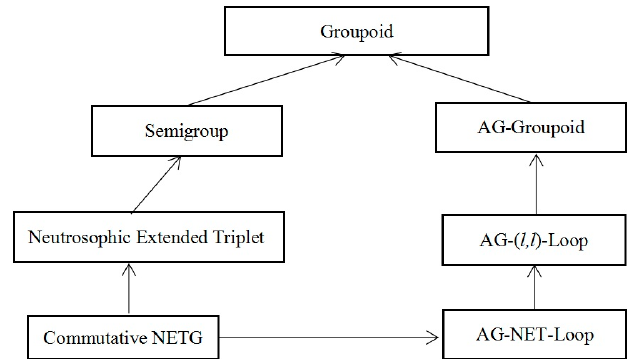
Figure 2. The relationships among various special groupoids.